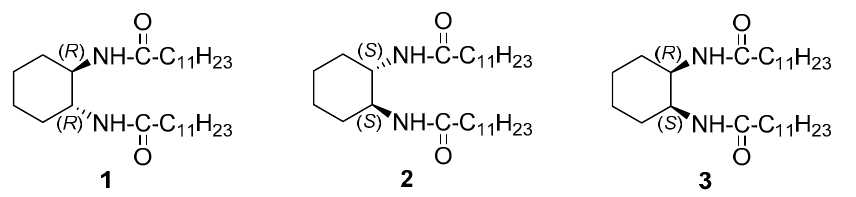
Figure 1. Cyclohexane-containing bisamides based on cyclohexane-1,2-diamine. Gels from acetonitrile were investigated by Transmission Electron Microscopy (TEM) revealing nano-sized helical fibers. The helicity was right-handed for ( R,R )- 1 and left- handed for its enantiomer, ( S,S )- 2 . As a result of Molecular Modeling (MD) studies, authors suggested that such structures are induced by the formation of two intermolecular hydrogen bonds between each molecule. Thus, the two-equatorial amide-NH and amide- CO could direct themselves antiparallel to each other and perpendicular to the cyclohexyl ring promoting the formation of an extended molecular tape (Figure 2). Although hydrogen bonding between amide groups in consecutive molecules has also been proposed by other authors in later studies to explain the self-assembling mode of related systems (see below), such a cyclohexane stacking has not been supported neither by experimental evidence nor by recent computational